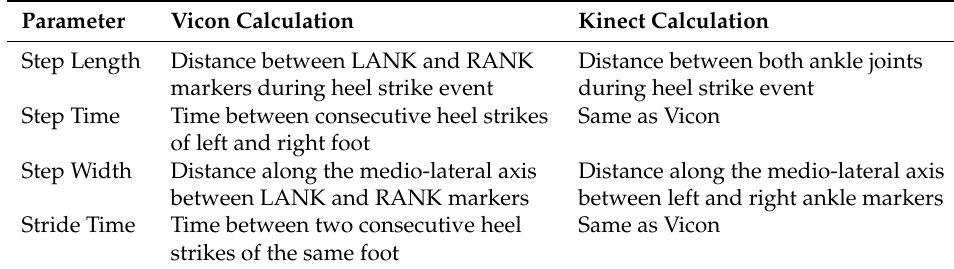
Table 2. Calculation of spatio-temporal gait parameters for Vicon and both Kinect sensors. LANK and RANK stand for the left and right ankle markers